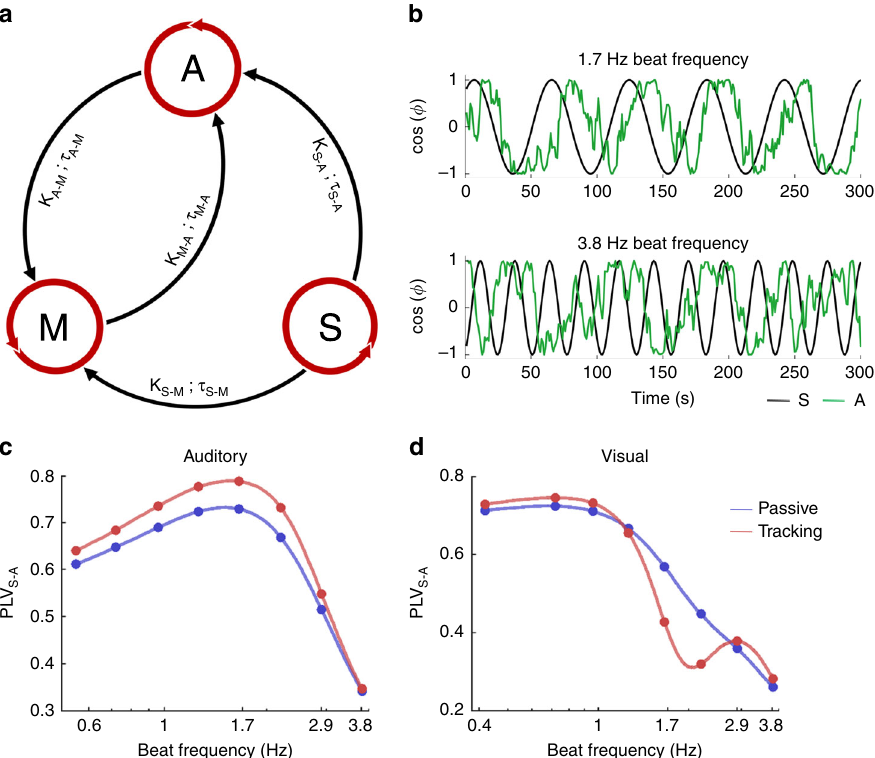
Fig. 5 A model of coupled oscillators to generalise the results. a Model of three delay-coupled phase oscillators approximating the selective coupling between the external beat (stimulus S), sensory-speci fi c temporal attention (A), and natural motor dynamics (M). The external oscillator (S) in fl uences attention and motor oscillators with a speci fi c strength K and delay τ , and attention and motor oscillators reciprocally in fl uence each other. The phase- locking value (PLV) between the external beat (S) and the sensory-speci fi c temporal attention oscillator (A) re fl ects the capacity of A to entrain to S and thus is used as an approximation of behavioural performance. b Example of dynamics of the auditory temporal attention oscillator (A; green) during presentation of an external beat (S; black) at 1.7 Hz or 3.8 Hz. c , d Replication of the ( c ) auditory (exp. 2) and ( d ) visual (exp. 5) passive (blue) and tracking (red) experiments. Difference between conditions was obtained by adjusting three key parameters: the natural frequency of the sensory-speci fi c temporal attention oscillator (A) and the time-delay between the stimulus (S) and the motor oscillator (M) which varied across modalities (auditory: ω = 1.5 Hz, τ = 0.1 s; visual: ω = 0.7 Hz, τ = 0.35 s), and the coupling strength between motor and attention oscillators, which varied between A A S − M S-M passive (K M − A = 2) and tracking (K M − A = 10)